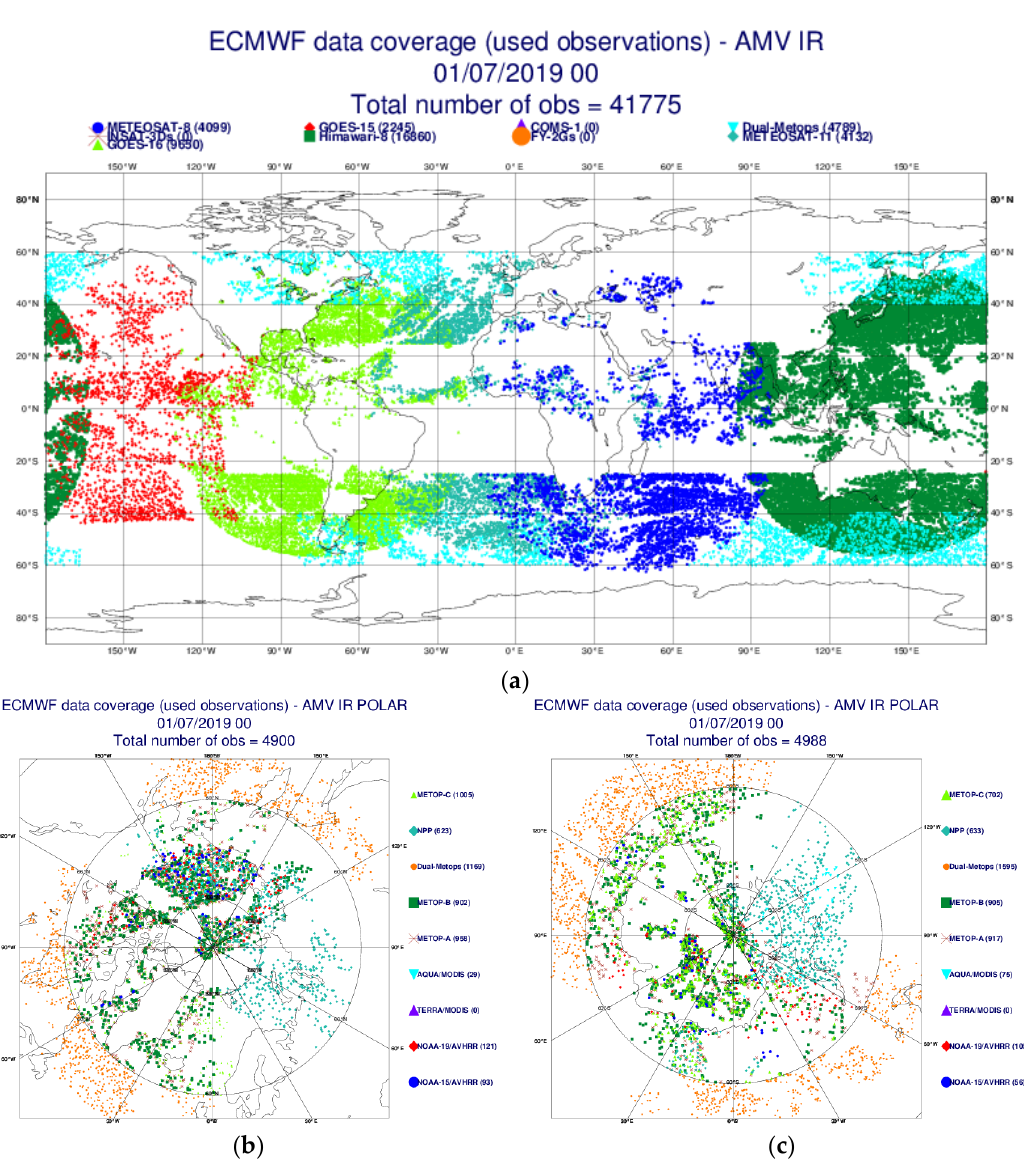
Figure 1. Illustration of European Organization for the Exploitation of Meteorological Satellites (EUMETSAT)’s contribution to the global atmospheric motion vector (AMV) production system over the geostationary satellite ring, with Meteosat-11 (dark turquoise) and Meteosat-8 (dark blue), and dual Advanced Very High-Resolution Radiometer (AVHRR) (cyan) AMV products ( a ) and over the northern (left) and southern (right) polar areas with Metop-A (red crosses), as well as the Metop-B (dark green) and Metop-C (light green) single and global AVHRR (orange) wind products ( b ). Images downloaded from ECMWF satellite data monitoring website for the 1 July 2019 at 00:00 UTC. Please note that the gap of data in the tropics in Figure 1a is due to the blacklisting filter used in assimilation process at ECMWF and not due to a lack of satellite data.